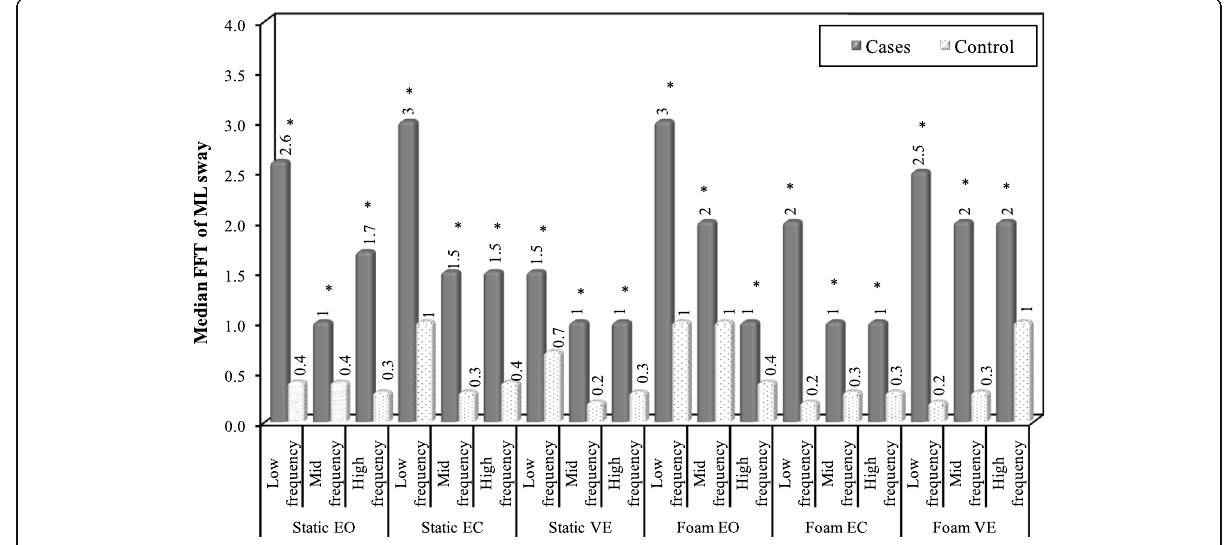
Fig. 2 Comparison of FFT of ML sway between cases and